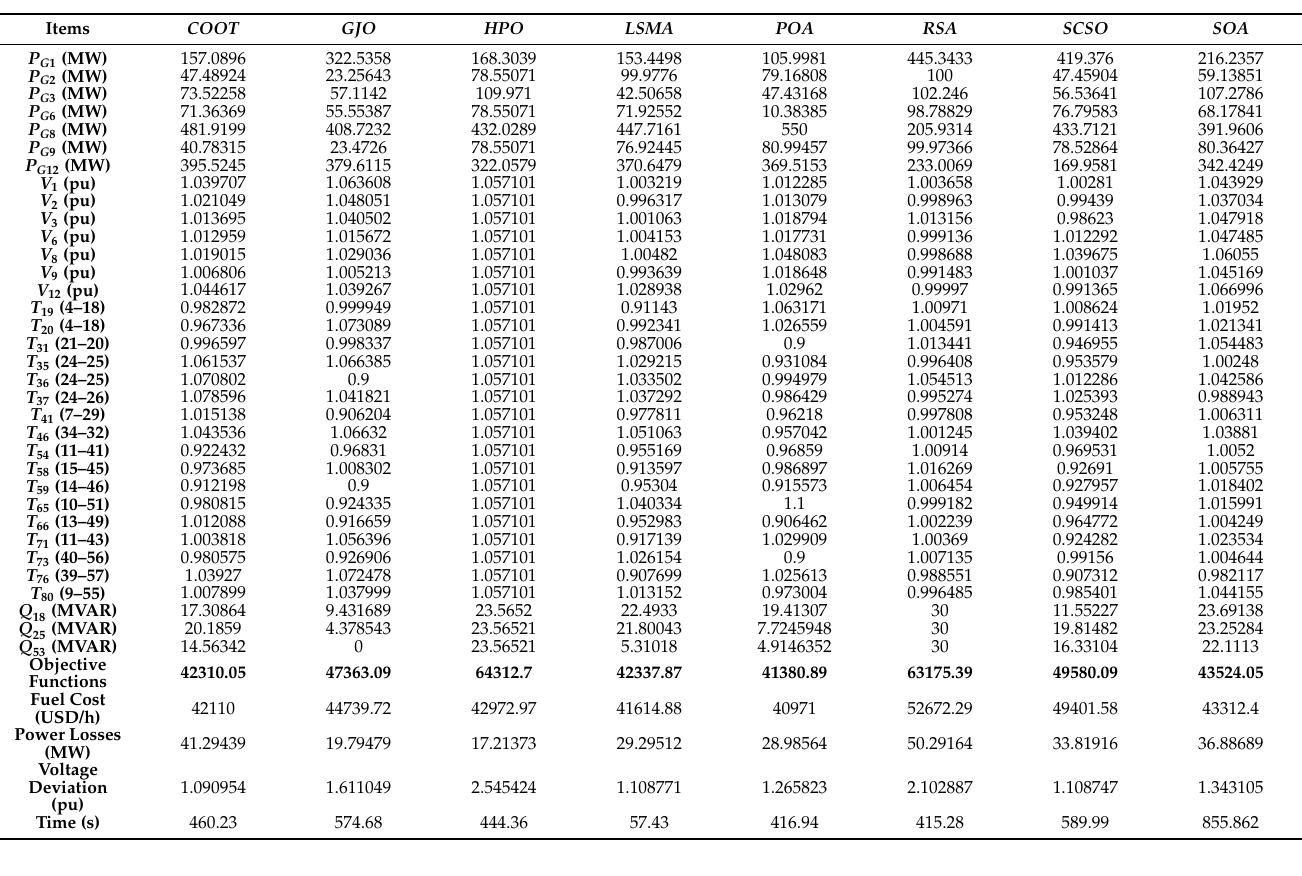
Table 11. Optimal control variables for the IEEE 57-bus test system for minimizing multi-objective function with emissions.